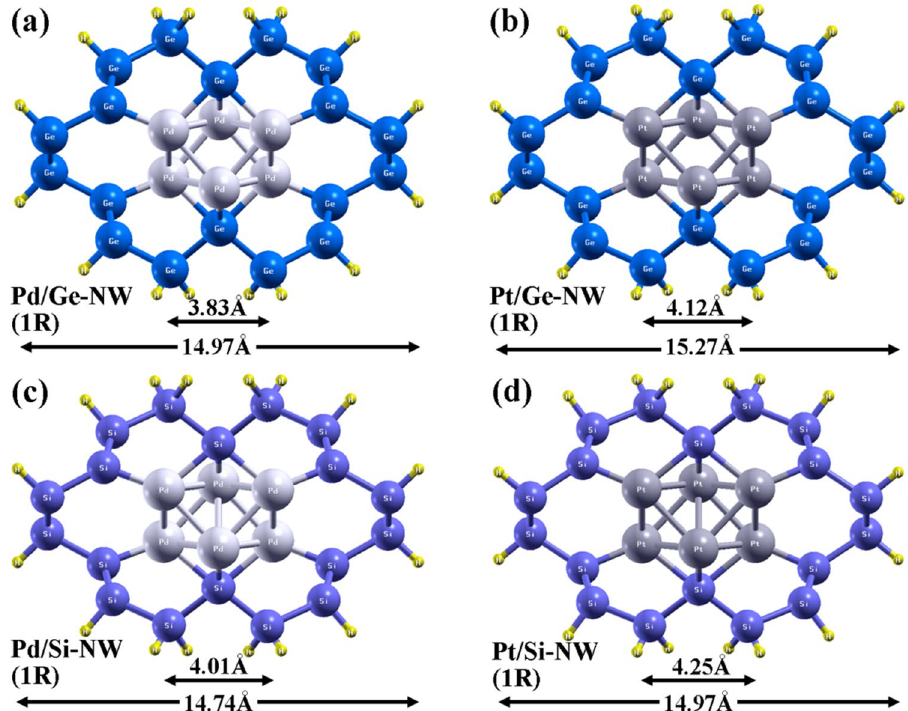
Figure 1. Front view of the fully optimized structures of ( a ) Pd/Ge, ( b ) Pt/Ge, ( c ) Pd/Si and ( d ) Pt/Si core–shell NWs. The core is wrapped by 1ML Ge or Si-shell. Hydrogen atoms are passivated on the surface of the NWs to prevent the dangling bonds.